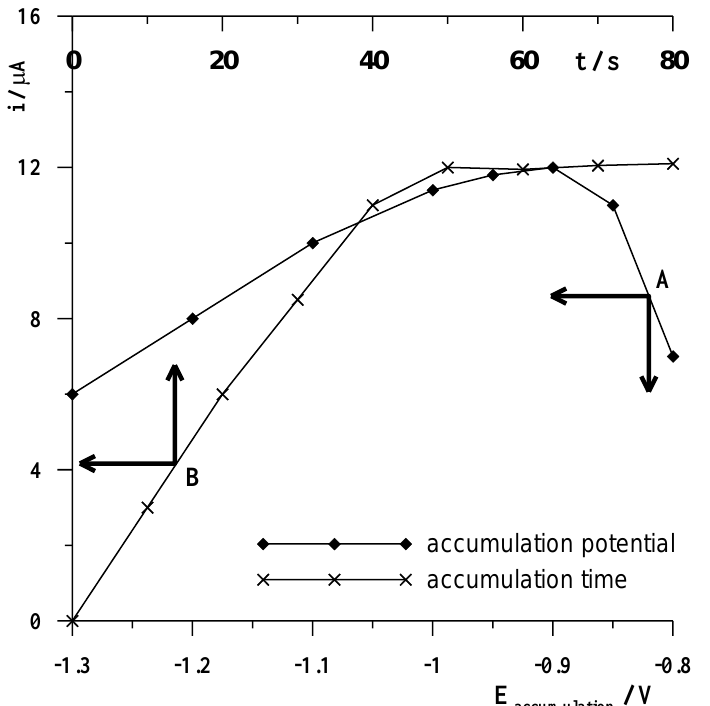
Figure 4. The influence of accumulation potential at a constant accumulation time of 50 s ( A ) and accumulation time at a constant accumulation potential of −0.9 V ( B ) on the voltammetric signal of 5 × 10 −8 mol L −1 Cd(II). Concentrations of 0.1 mol L –1 acetate buffer at pH = 3 ± 0.1 and 1.5 × 10 −4 mol L −1 Bi(III).